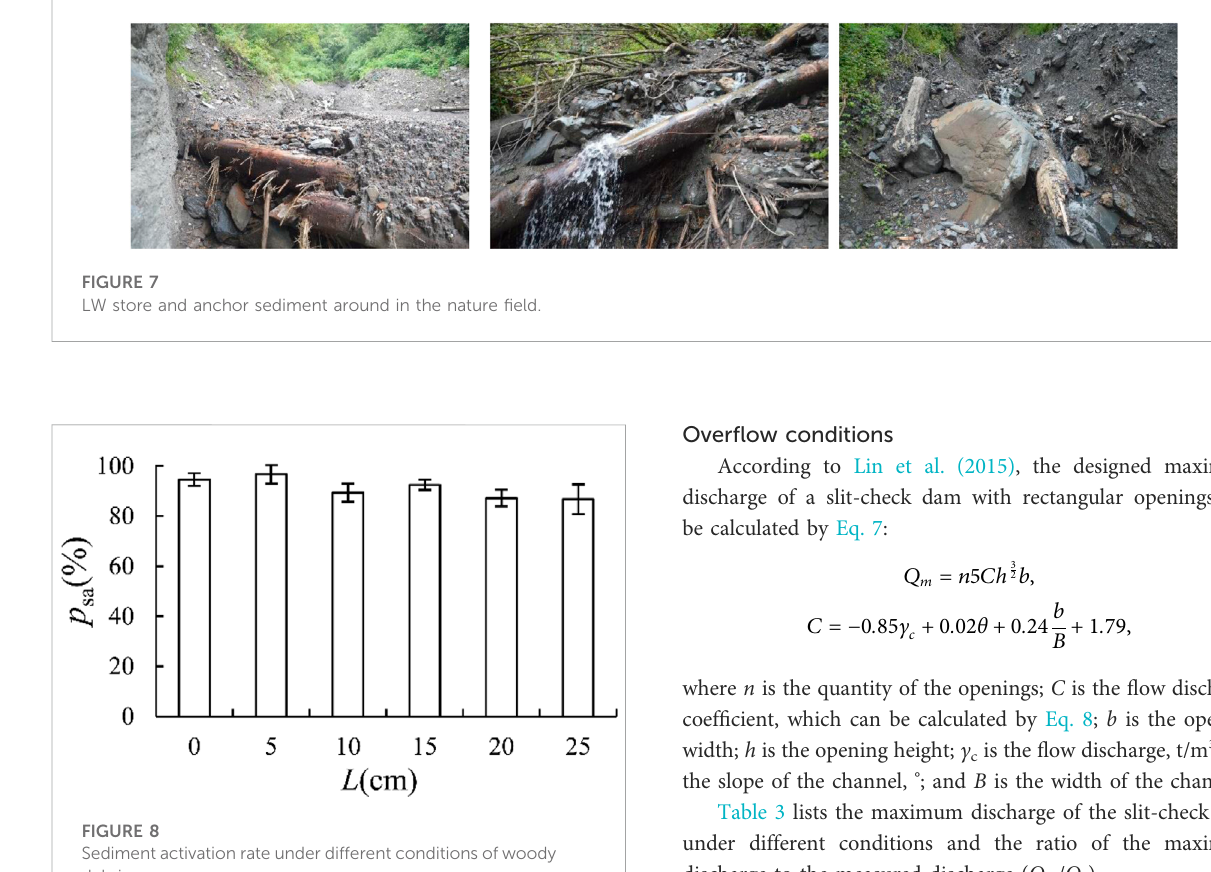
FIGURE 8 Sediment activation rate under different conditions of woody